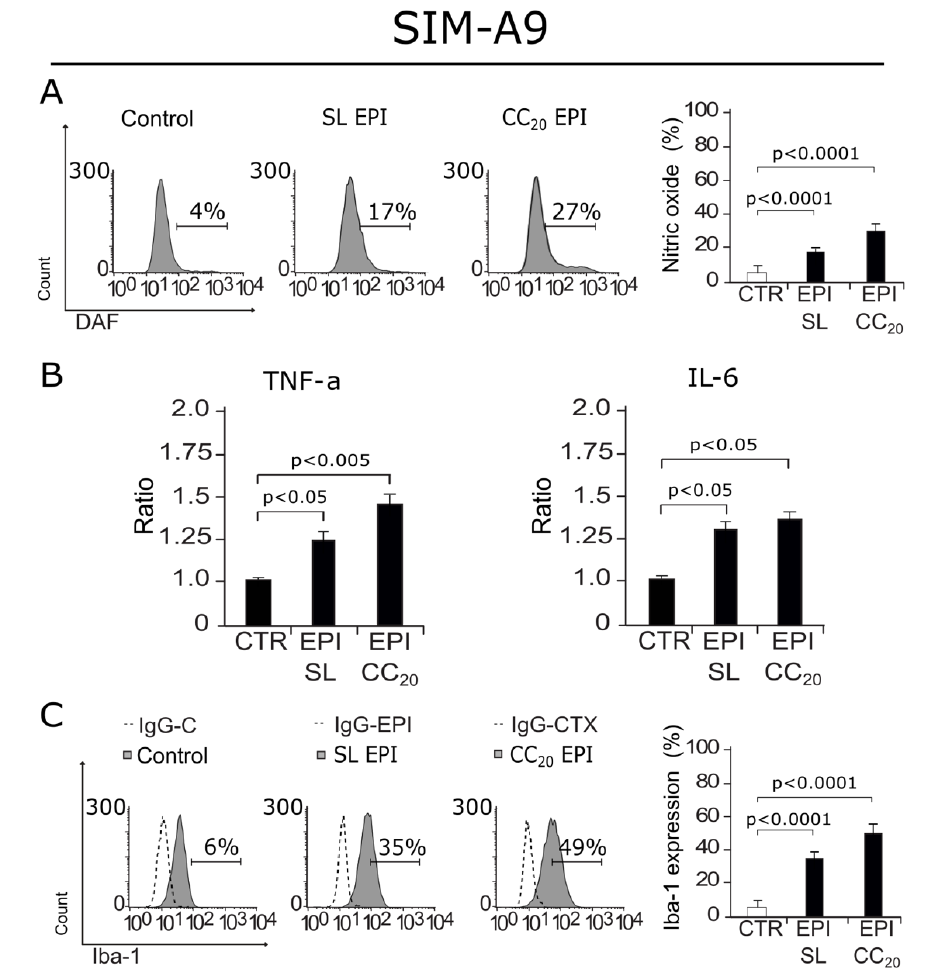
Figure 7: NO production, cytokine release and Iba-1 expression after SIM-A9 treatment with EPI. A ) Representative histograms of Nitric oxide (NO) (left) production measured through DAF staining, bar graphs presenting mean  SD (right) are shown. B ) Bar graphs displaying mean  SD of TNF-α and IL- 6 cytokine release assessed in SIM-A9 cells treated for 24 hours with sub-lethal (SL) concentration of EPI or EPI CC 20 . C ) Representative histograms of Iba-1(left) expression assessed by anti-Iba-1 anti- body, bar graphs presenting mean  SD (right) are